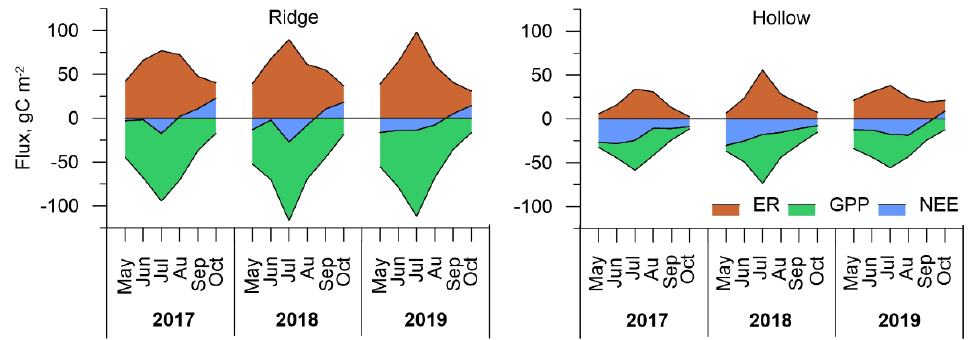
Figure 6. Monthly carbon dioxide fluxes at the ridge and the hollow sites at Mukhrino bog in 2017–2019.